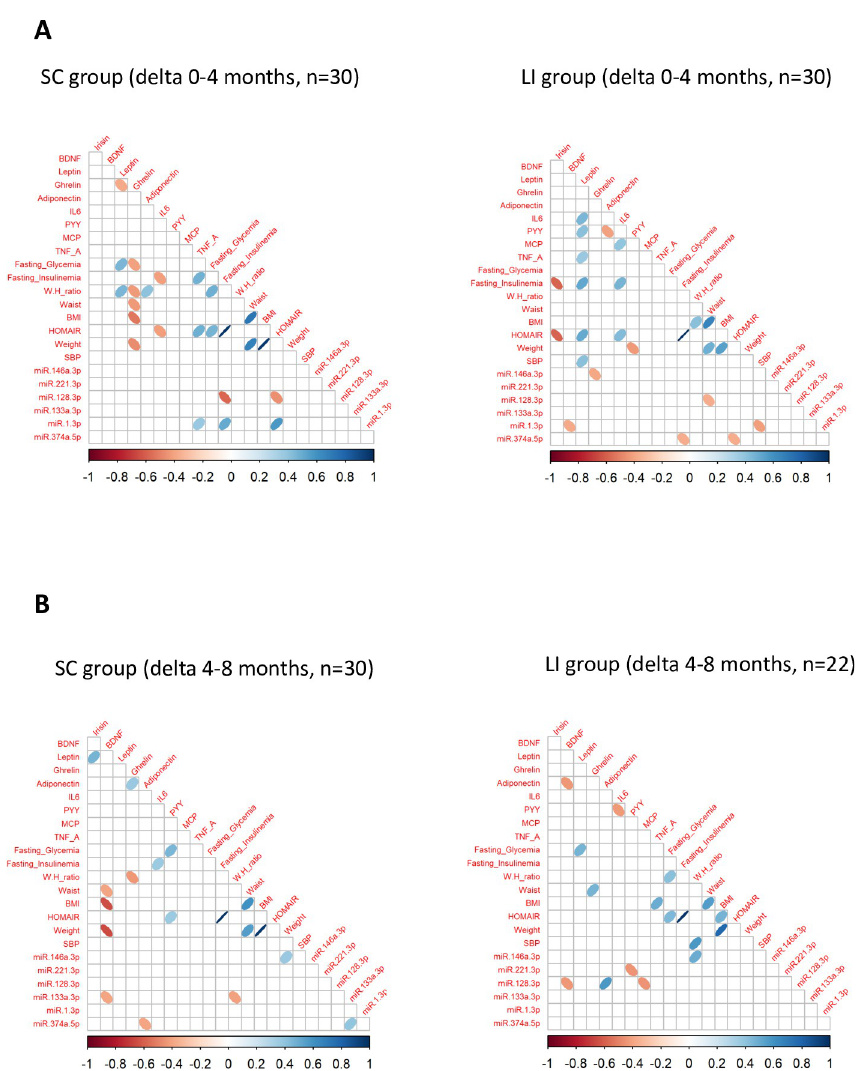
Fig 3. Spearman correlations between variations of c-miRNA levels and variations of metabolic parameters and cytokine concentrations. As after months, 8 patients from the LI group received metformin, they were removed from the